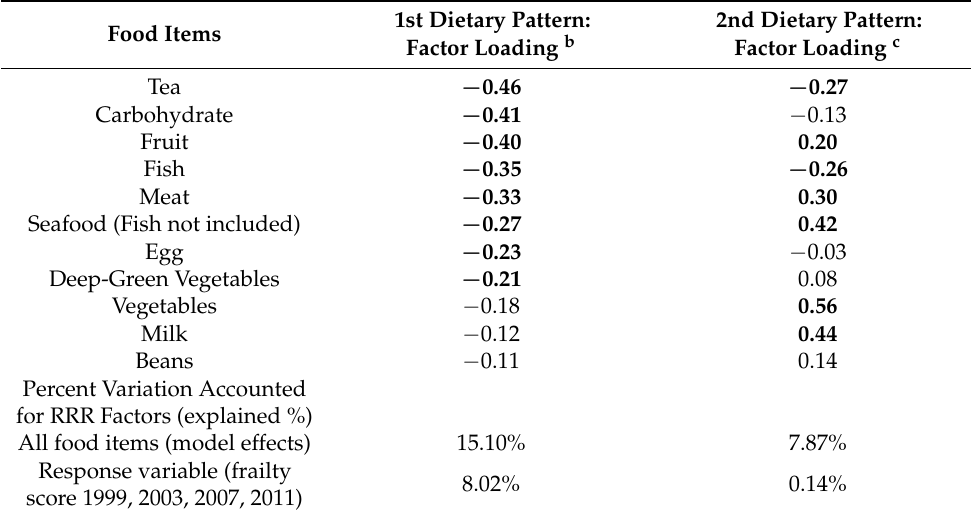
Table 1. Dietary patterns derived through reduced rank regression of food item data from the